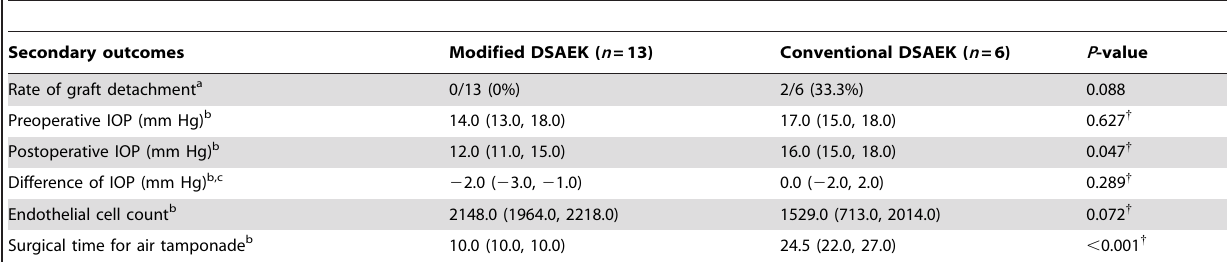
Table 2. Postoperative clinical features compared between patients who received modified DSAEK and those who received conventional